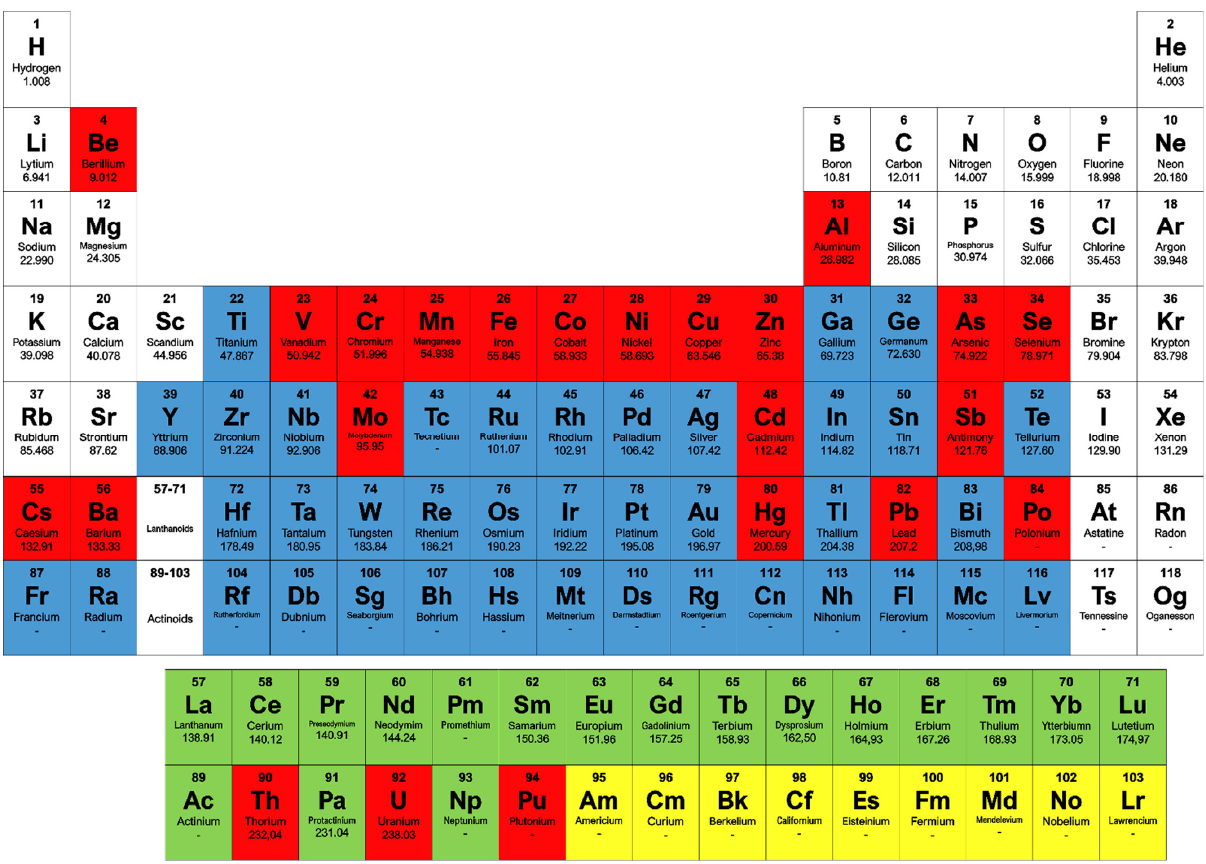
Figure 1. Periodic table of elements. Metals/metalloids are highlighted on the basis of the main characteristic that define them as “heavy”: density > 5 g/cm 3 ( blue ); toxic ( red ); rare ( green ); synthetic ( yellow ).